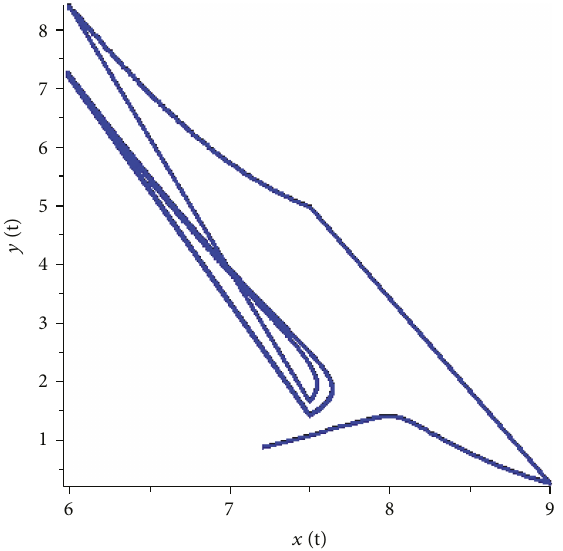
Figure 20: There exists an order-2 periodic solution in system (16) with q 1 = 1/6 , p = 0 9 , and τ = 4 7 .